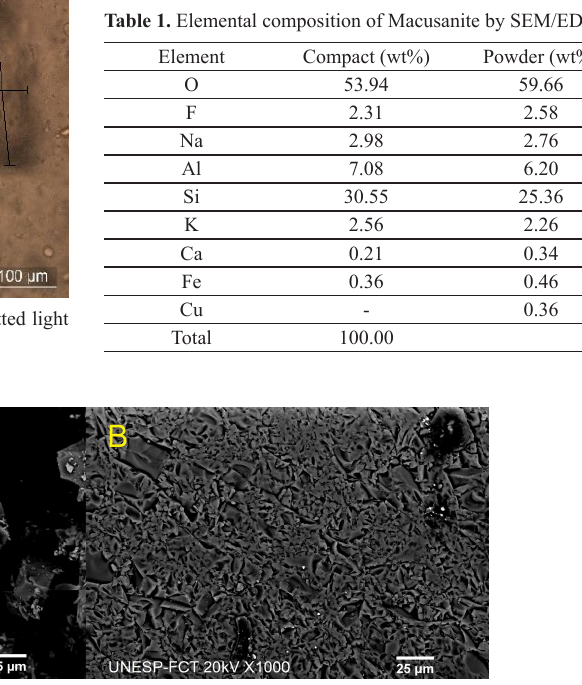
Figure 3. SEM images of Macusanite in powder (a) and compact (b) form with a total magnification of 1000x via BSD detector.